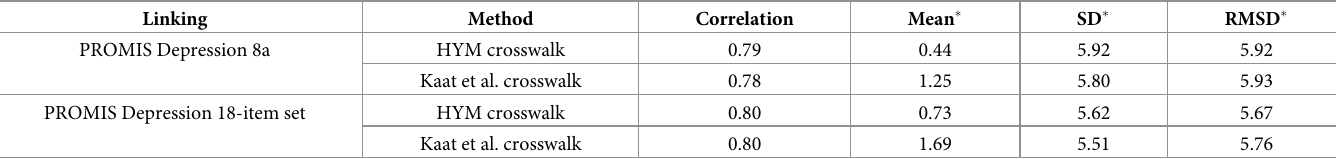
Table 4. The difference between the observed and crosswalk-derived T scores in the HYM sample.